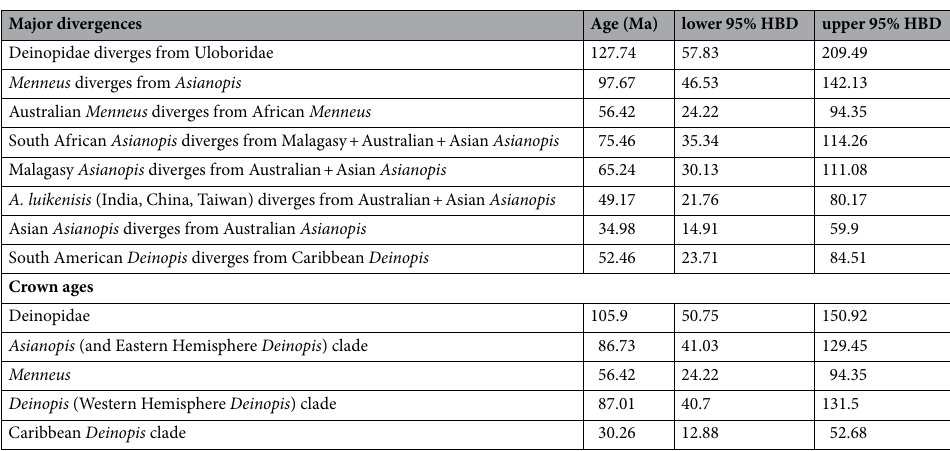
Table 1. Divergence times and average marginal likelihoods and 95% HPD of deinopids based on UCE + COI concatenated MCC phylogeny.